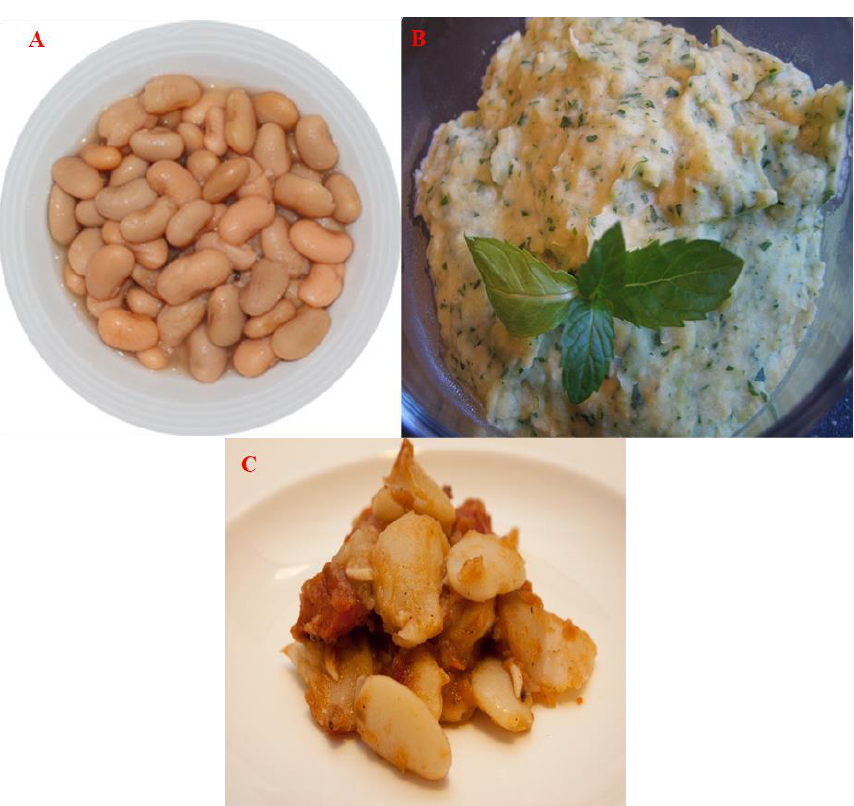
Figure 4. Foods from lima beans ( A ) Canned lima bean [5] ( B ) Lima beans dip [121] ( C ) Baked lima beans